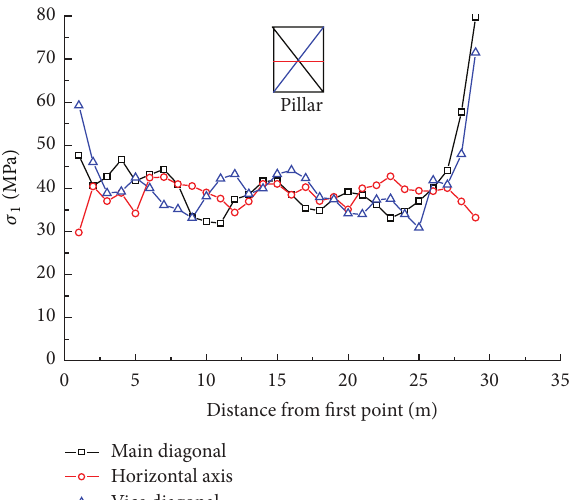
Figure 22: Variation of 𝜎 1 with distance from the first point (dip angle = 0 ∘ ).